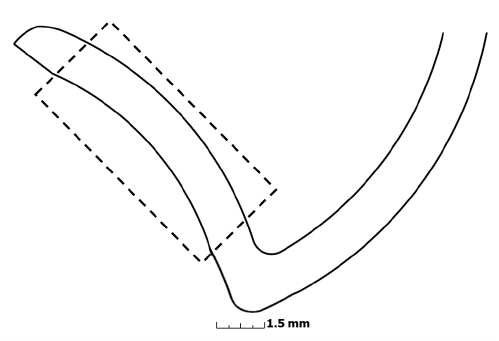
Figure 1. Simplified design of the component: cross sectional view. Table 1. Main properties of the material.